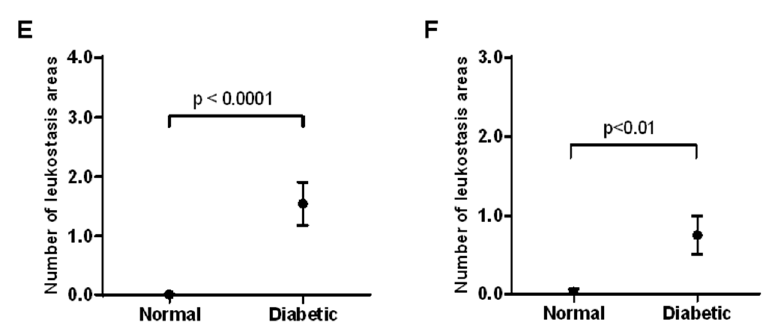
Figure 3. Effect of diabetes on leukostasis. Representative intravital microscopy confocal images of microcirculation showing clustered neutrophils (in green) indicative of leukostasis areas in the cremaster muscle of ( A ) normal and ( B ) diabetic mice, and in the ear lobe of ( C ) normal and ( D ) diabetic mice. Mean values (± standard deviation) of leukostasis areas in the cremaster ( E ) and ear lobe ( F ) in normal and diabetic mice ( n = 6) over a period of 5 months. Diabetic mice exhibited increased number of leukostasis areas in both cremaster muscle ( p < 0.0001) and ear lobe ( p < 0.01) compared to those of normal mice.